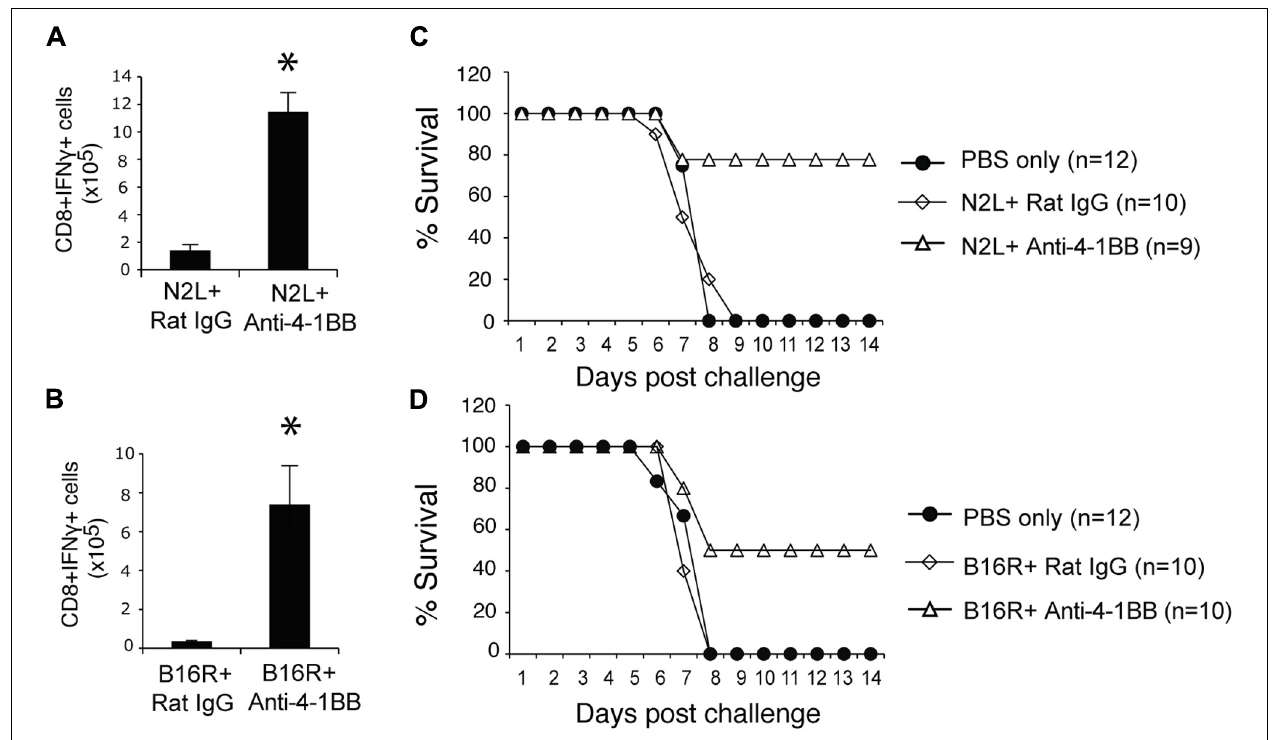
FIGURE 7 |Anti-4-1BB promotes protective CD8T cells with vaccination with subdominantVACV peptides. WT mice were immunized s.c. at the base of the tail with 10 μ g of N2L (A,C) or B16R (BD) peptide in IFA and treated with 100 μ g anti-4-1BB antibody or rat IgG as on day 1. (A,B) 7 days after vaccination, splenocytes from N2L peptide vaccinated animals were stimulated with N2L peptide, and splenocytes from B16R peptide vaccinated animals were stimulated with B16R peptide.Total numbers of CD8 + IFN- γ +